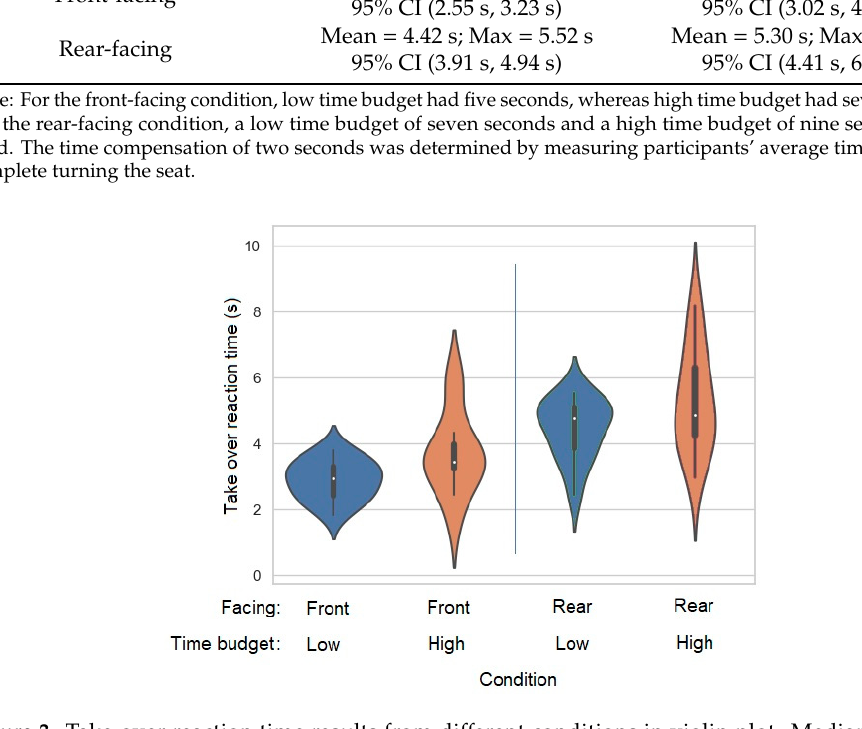
Figure 3. Take-over reaction time results from different conditions in violin plot. Median is shown by the white dot. Interquartile range is shown by the black bar. The range between the lower/upper adjacent values is shown by the black line. The violin shape shows the probability density smoothed by kernel density estimation. The plot was generated using the Seaborn library in Python.